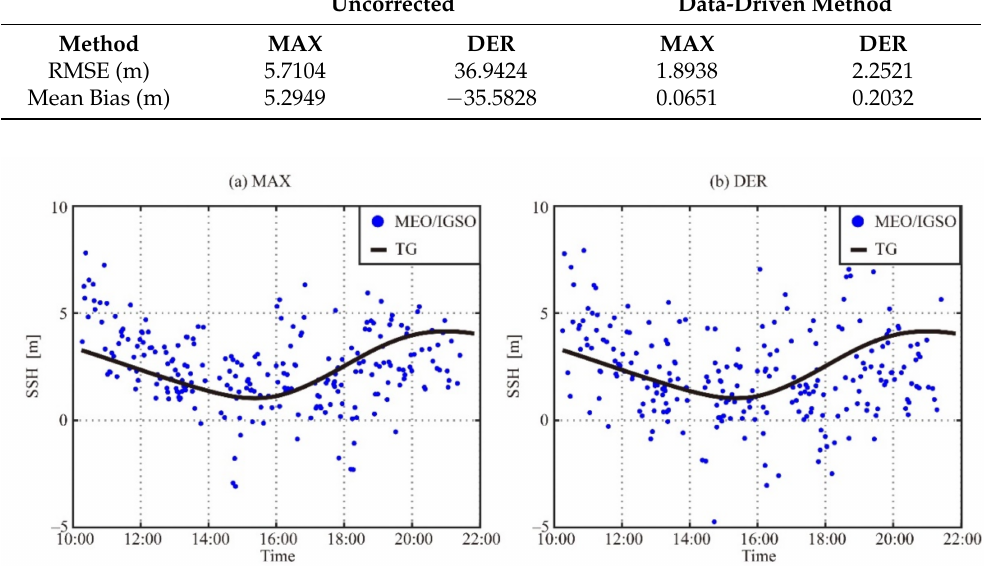
Figure 14. Scatter plot of the ocean altimetry results obtained after correction of elevation angle influence using the data-driven function. ( a , b ) are the height of the coastal receiver relative to the sea surface obtained using different signals and types of characteristic